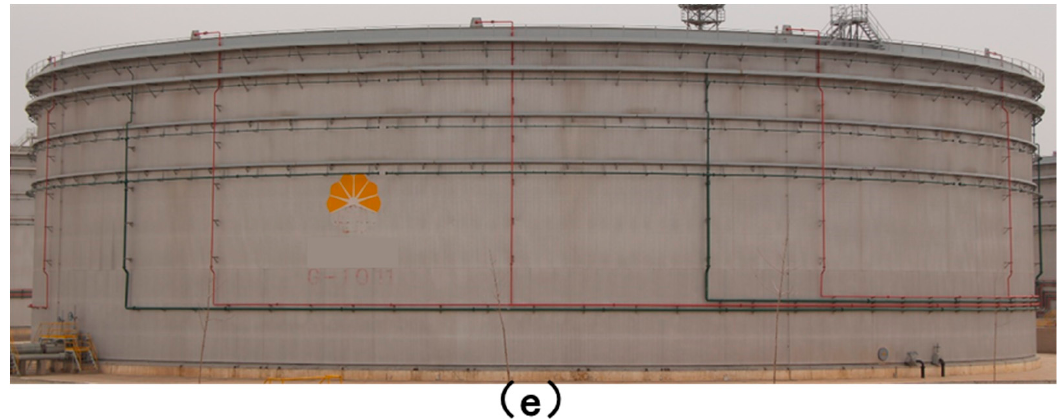
Figure 10. Experiments on test area: ( a ) Google Earth image; ( b ) SAR image; ( c ) coherence image; ( d ) and ( c ) a zoom of target building in red rectangle in ( a ) and ( b ); and ( e ) target building (oil storage silo with a height of 26 m) on the test line.